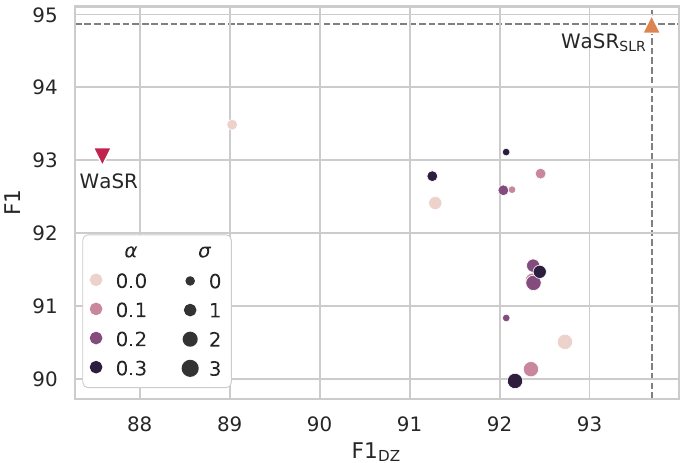
Figure 6. SLR pseudo-label estimation from weak annotations outperforms all combinations of spatial ( σ ) and pixel-wise ( α ) label smoothing of dense GT in terms of overall and within danger zone obstacle detection F1